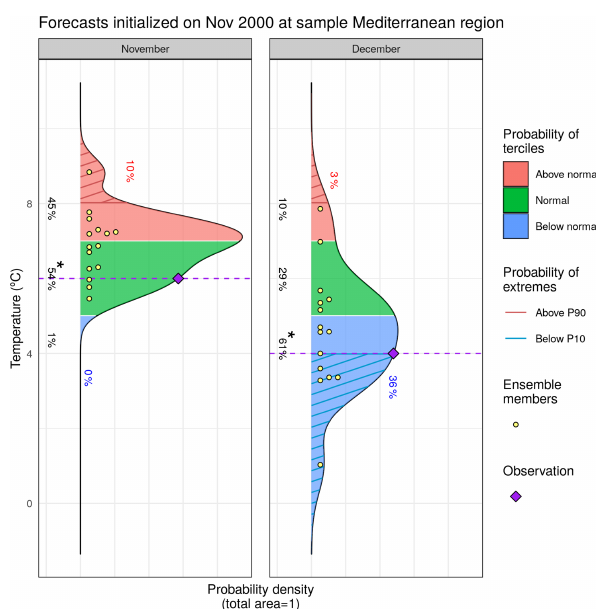
Figure 4. Example of a PlotForecastPDF result, using the lon- lat_data sample provided along with CSTools, showing a possible comparison of two different lead times for a given forecast in a specific location. The individual ensembles (yellow dots), the cor- responding observation (purple diamond), the probability of each tercile, i.e., above normal (pink), normal (green), and below nor- mal (blue), are annotated, and the one with highest probability is marked with an asterisk and the extreme limits, i.e., above the 90th percentile (red) and below the 10th percentile (blue) correspond to the hatched areas and are also annotated.